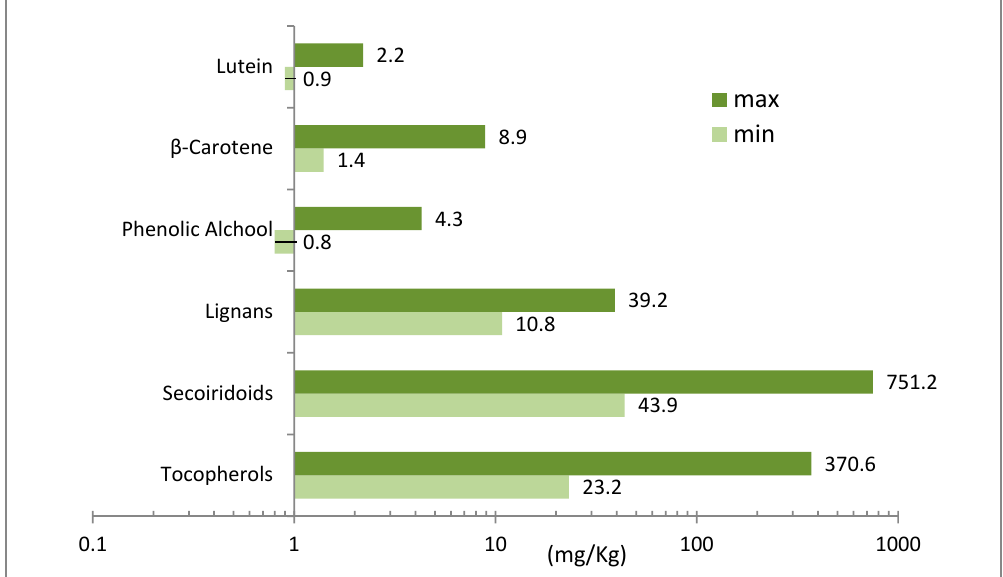
Figure 1. Minimum and maximum concentration of the main antioxidants in extra virgin olive oil (EVOO) from different Italian regions. Values are compared using a logarithmic scale. Adapted from Antonini et al. [10], Ninfali et al. [11] and Psomiadou et al. [12].